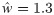
Dynamical states of the SOM-VIP motif.(A) Left: Bifurcation diagram reveals distinct operation modes: all interneurons are active (divided into amplification (a) and attenuation regime (b)), a winner-take-all (WTA) regime implementing a switch (c) and an oscillation regime (d). Regime boundaries (black lines) are obtained from a mathematical analysis (see S1 Appendix). Right: Example firing rate traces for all SOM (blue) and VIP (green) neurons for four network settings taken from the bifurcation diagram (cf. markers). Adaptation time constant τa = 50 ms. (B) The oscillation frequency in the oscillation regime depends on the adaptation strength (left), the adaptation time constant (right) and the total mutual inhibition strength (black: w^=1.3, gray: w^=1.4). Left: τa = 50 ms, right: b = 1. The frequencies cover a broad range from Delta to Alpha oscillations. (C) When short-term facilitation (STF) is present, the WTA (switch) regime is enlarged and the oscillation mode requires stronger adaptation. Initial synaptic efficacy Us = 0.1, facilitation time constant τf = 100 ms.